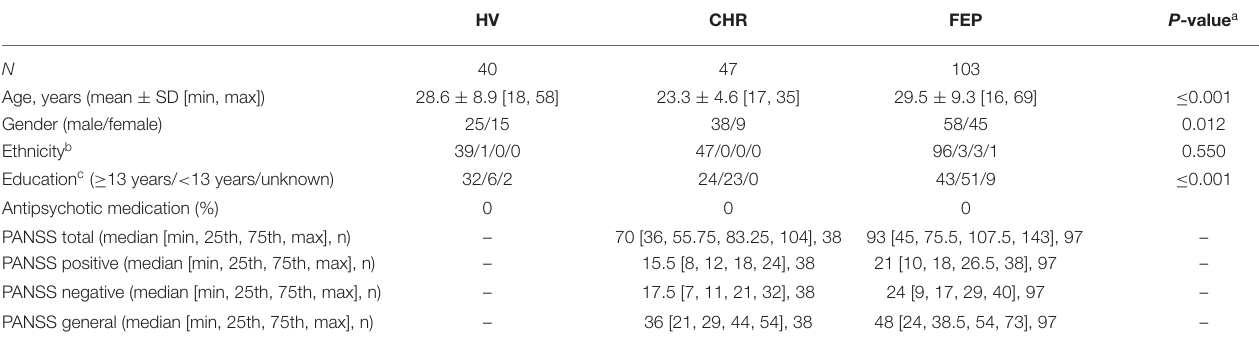
TABLE 1 | Demographic and clinical information of the study